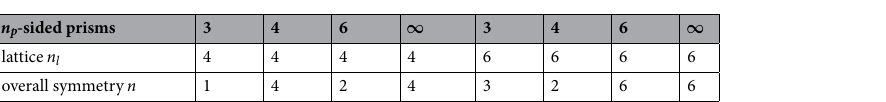
Figure 2. Backscattering ratio R b of different n -sided prisms (legend) with permittivity ε r permeability around the duality point ε r